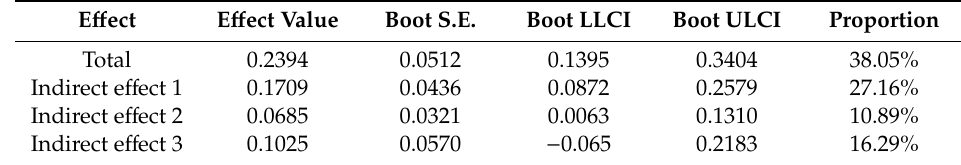
Table 7. Mediating e ff ects of job burnout and perceived insider status. E ff ect E ff ect Value Boot S.E. Boot LLCI Boot